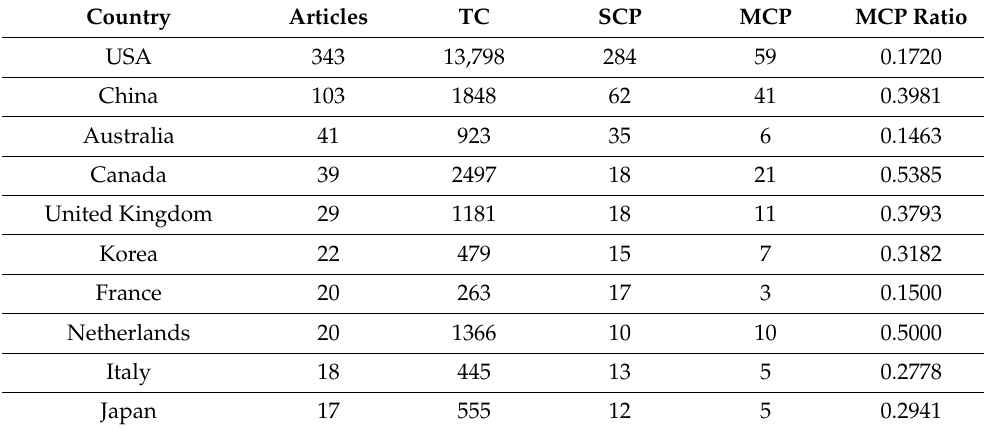
Table 5. Top countries that published regarding environmental toxicants and pollutants and preterm